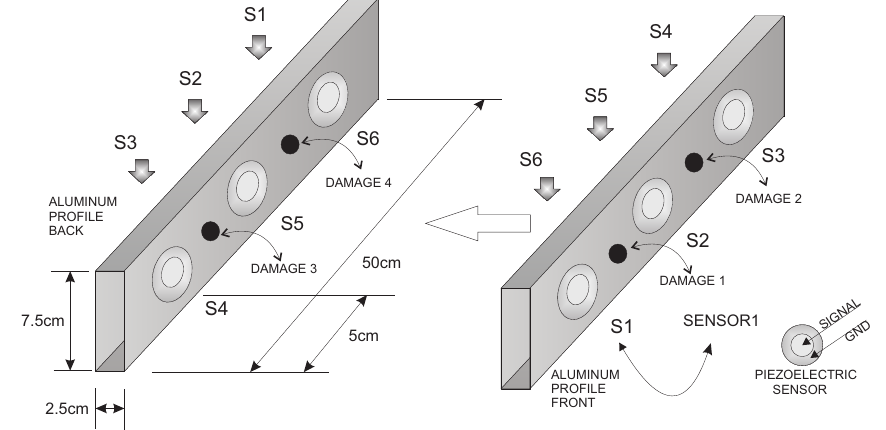
Figure 12. Aluminum rectangular profile instrumented with six piezoelectric